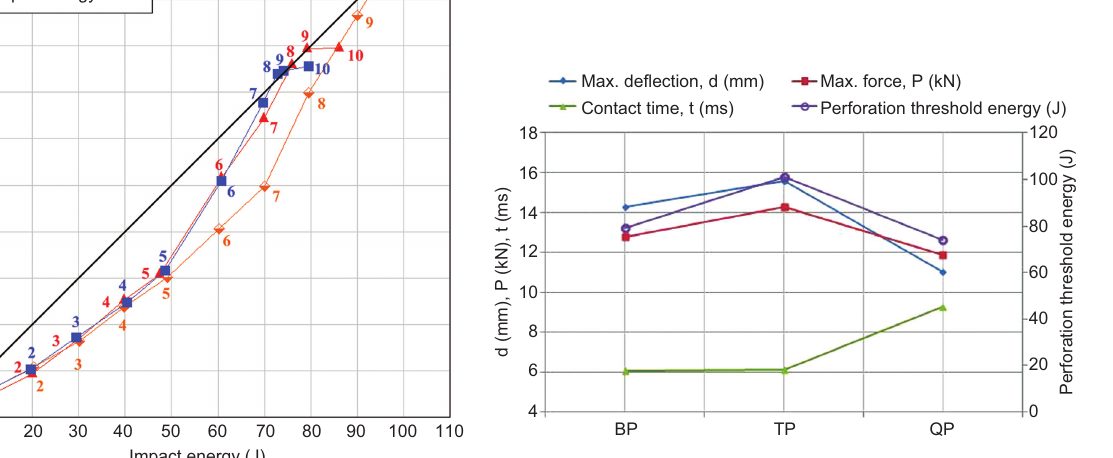
Figure 4 Energy profile diagram.